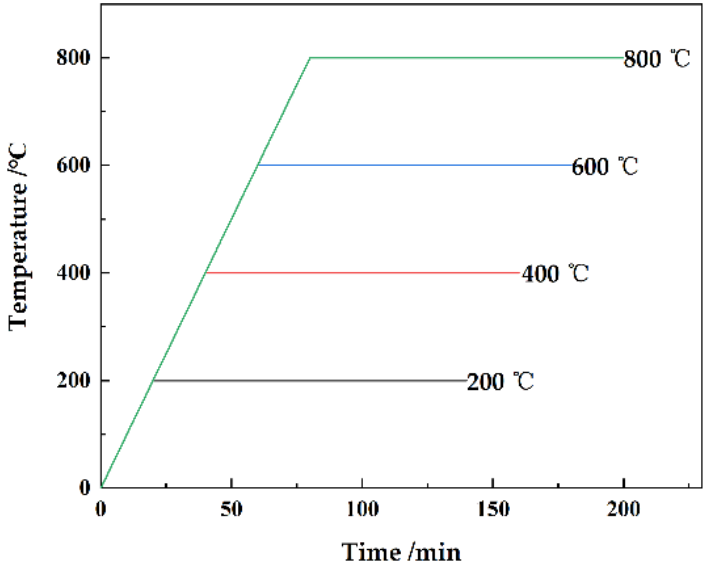
Figure 5. Heating temperature control curve.